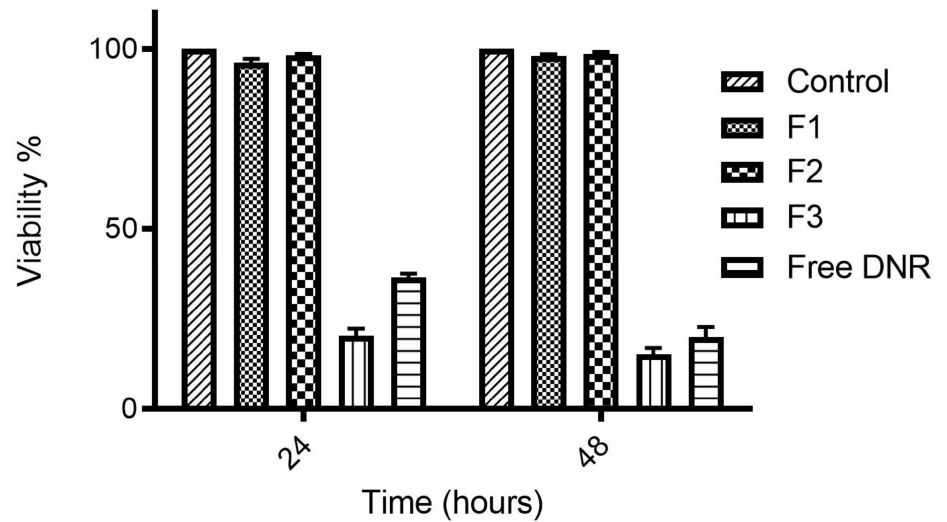
Figure 3. Cytotoxic activity (MTT assay) of different types of TSLs (F1 and F2) compared to F3 and free DNR. The cytotoxic activity of DNR loaded TSLs was studied at 14 µ M DNR at 37 ◦ C on MDA-MB-231cell lines. Values represent mean ± standard deviation ( n =